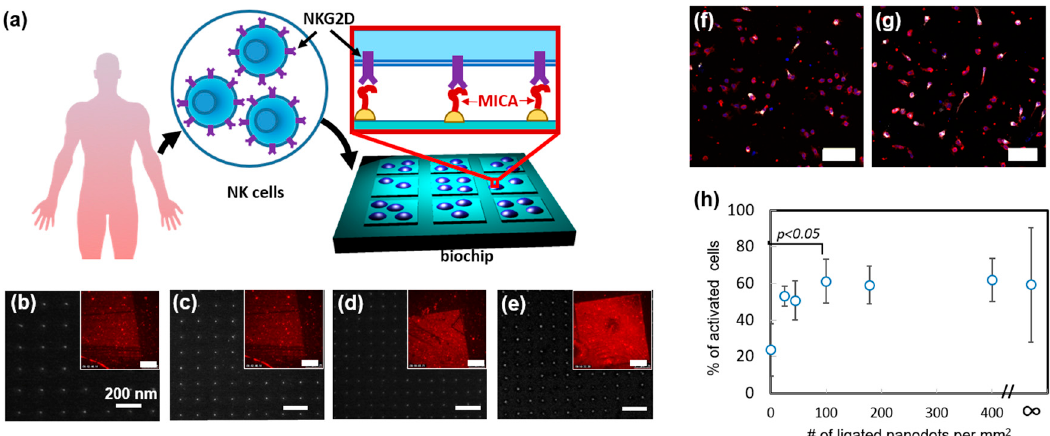
Figure 4. Nanoimprinted chip for the study of the role of the spatial distribution of activating receptors in the immune activation of NK cells. ( a ) Scheme of the chip ( b – e ) SEM images of nanodot in different matrices with the periodicity of 200, 150, 100, and 50 nm, receptively. Scale bar: 200 nm. Insets: Florescent image of the matrices functionalized wit MICA and immunostained with AlexaFluor 568 tagged antibody. Scale bar in insets: 50 µ m. ( f , g ). Fluorescent imaging of CD107a (white) in the NK cells activated on the matrices with 400 nanodots per µ m 2 and 50 nanodots per µ m 2 , respectively. The cells were also stained for cytoskeleton (red), nuclei (blue). Scale bars: 50 µ m ( h ) % of activated cells vs. the nanodot density. Here ∞ means continues AuPd layer functionalized with MICA, providing the maximal ligand density. Analysis of variance was performed to assess the significant changes in the percentage of activated cells on different matrices. The results were considered significant for p < 0.05. Reproduced from Reference [45] with permission from The Royal Society of Chemistry.